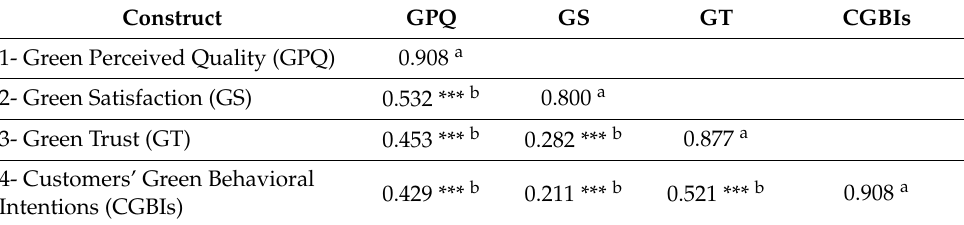
Table 3. Discriminant Validity Based on the Fornell–Larcker Criterion. Construct GPQ GS GT CGBIs